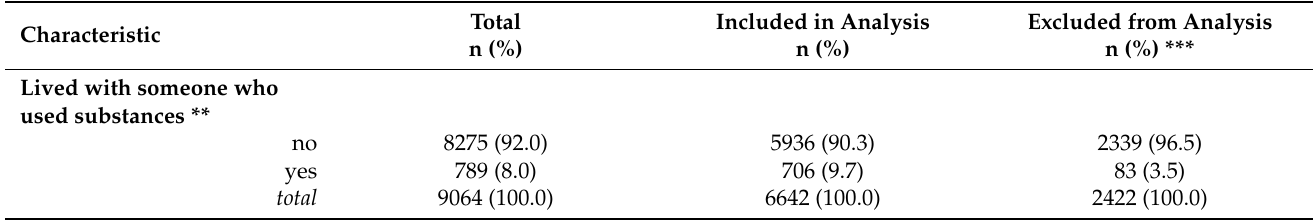
Table 3. Descriptive characteristics of those included and excluded from the analysis—2019 National Health Interview Survey